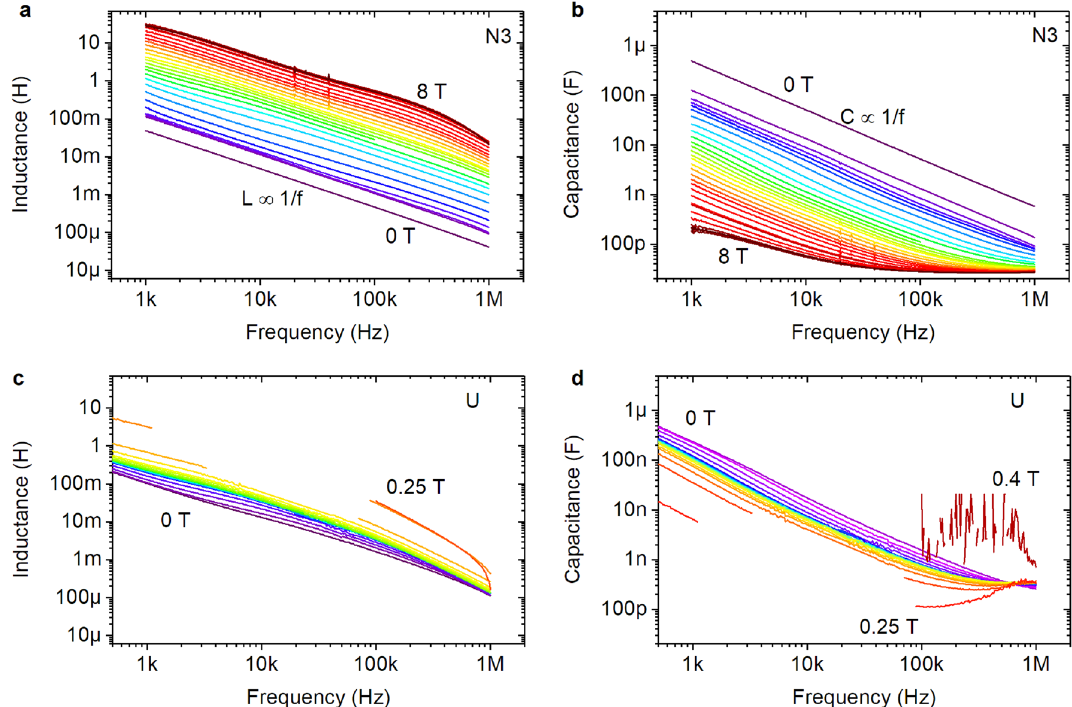
Figure 7. Frequency dependencies of the inductive and capacitive components of films complex impedance. ( a ) Frequency dependencies of the inductance of sample N3 at 0.2 K in different magnetic field. ( b ) Frequency dependencies of the capacitance of sample N3 at 0.2 K in different magnetic field. ( c ) Frequency dependencies of the inductance of sample U at 0.035 K in different magnetic field. ( d ) Frequency dependencies of the capacitance of sample U at 0.035 K in different magnetic field resulting from the analysis of the data presented in Fig. 4 a,b